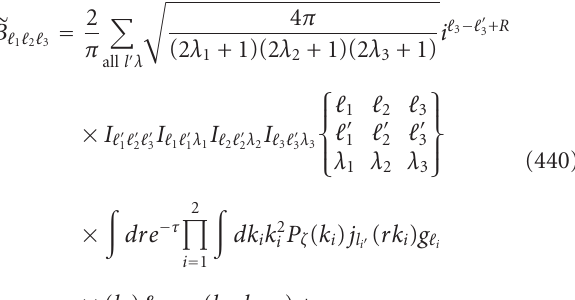
Wigner 9 j coe ffi cients are invariant under the